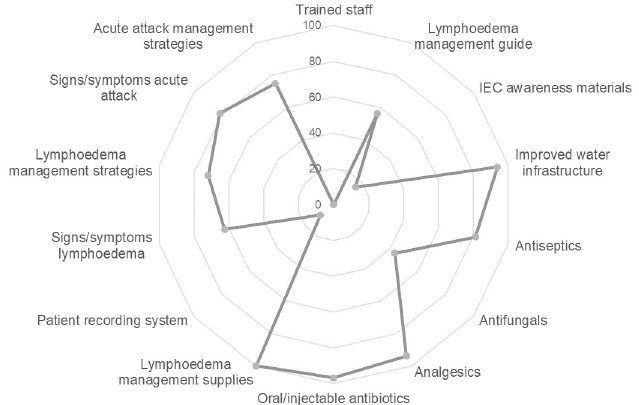
Fig 2. Percentage of facilities (n = 32) achieving quality indicator criteria. Percentage of health facilities nationally meeting the criteria for each of the 14 lymphedema management quality indicators.